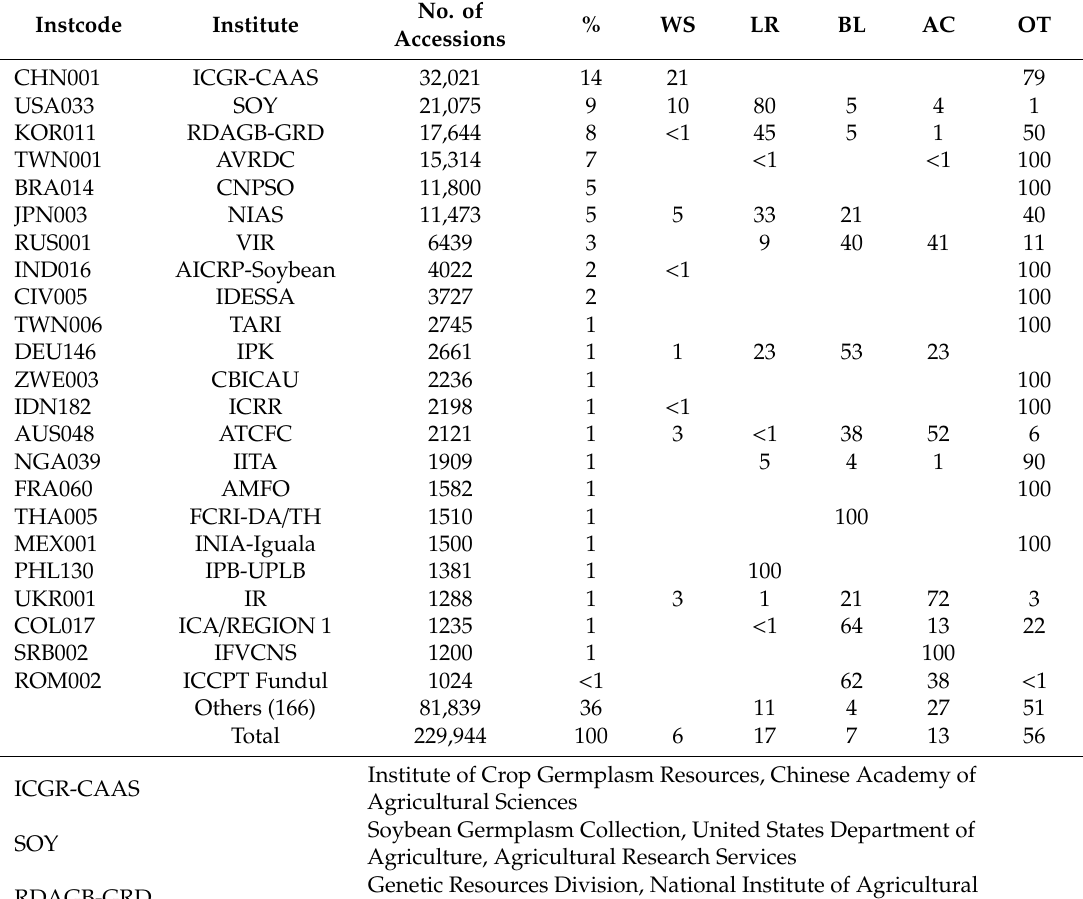
Table 2. Global soybean germplasm collections by